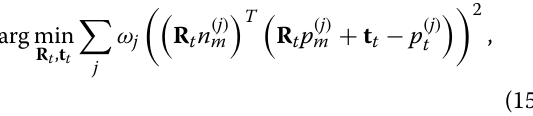
between ˆ p ∗ and ˆ p ∗ , and (2) orientation of ˆ p ∗ t b . to ˆ p ∗ t